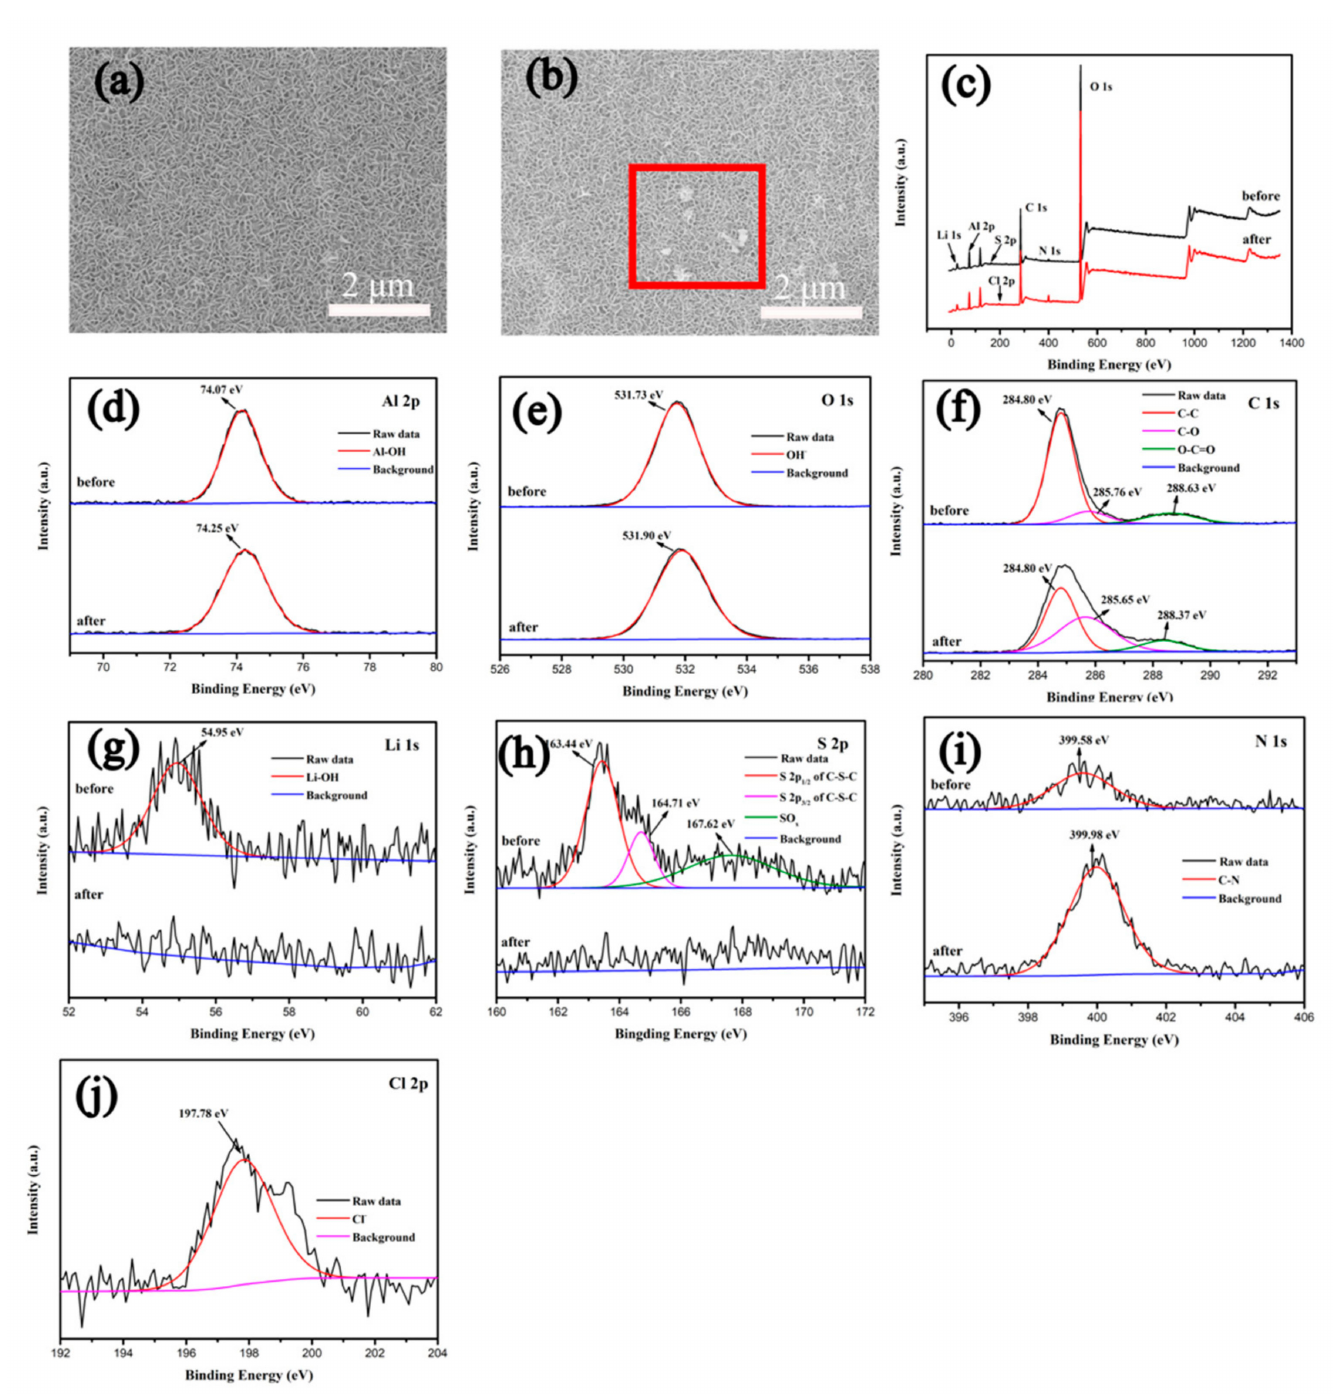
Figure 4. Surface morphology of MLDHs before ( a ) and after ( b ) immersion for 21 d; XPS spectra of MLDHs before and after immersion for 21 d: full-spectrum ( c ), high-resolution spectra of Al2p ( d ), O1s ( e ), C1s ( f ), Li1s ( g ), S2p ( h ), N1s ( i ); high-resolution spectra of Cl2p of MLDHs after immersion ( j